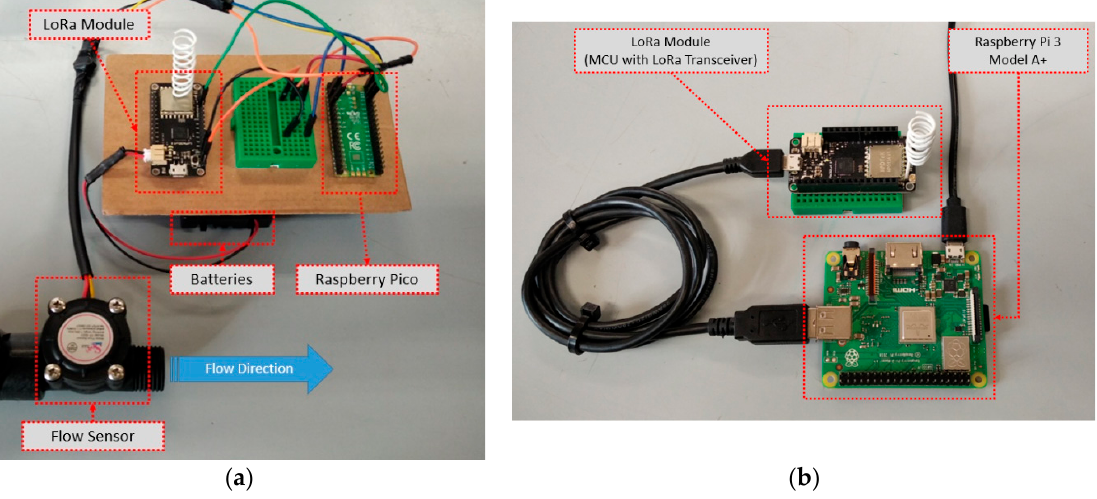
Figure 4. ( a ) Smart water sensor node deployment using Raspberry Pi Pico and LoRa radio; ( b ) Gateway/sink node implementation using Raspberry Pi 3 Model A+ and LoRa radio;.